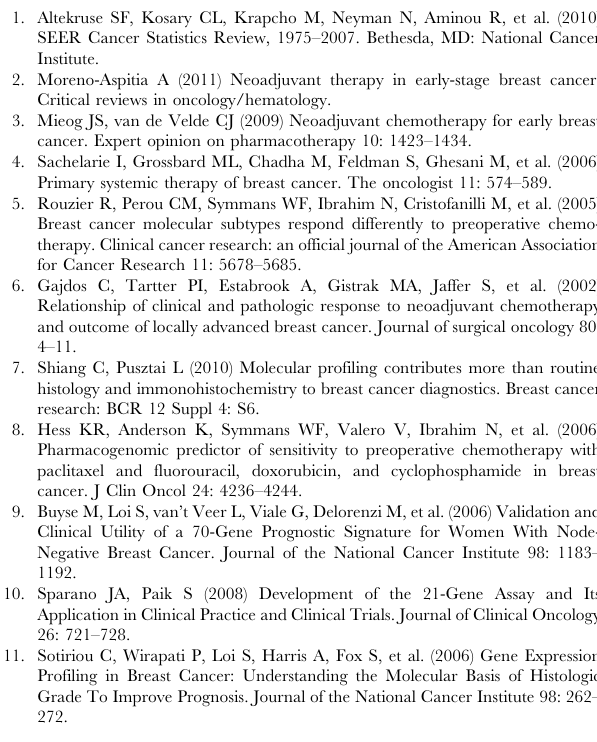
Table S10 MGP-TFAC developed from the ER positive Neve training set by the COXEN method. (DOC) Table S11 MGP-TFAC developed from the ER negative Neve training set by the COXEN method. (DOC) Table S12 MGP-TFAC developed from the ER positive Hoeflich training set by the COXEN method. (DOC) Table S13 MGP-TFAC developed from the ER negative Hoeflich training set by the COXEN method. (DOC) Table S14 MGP-FEC developed from the ER positive Neve training set by the COXEN method. (DOC) Table S15 MGP-FEC developed from the ER negative Neve training set by the COXEN method. (DOC) Table S16 MGP-FEC developed from the ER positive Hoeflich training set by the COXEN method. (DOC) Table S17 MGP-FEC developed from the ER negative Hoeflich training set by the COXEN